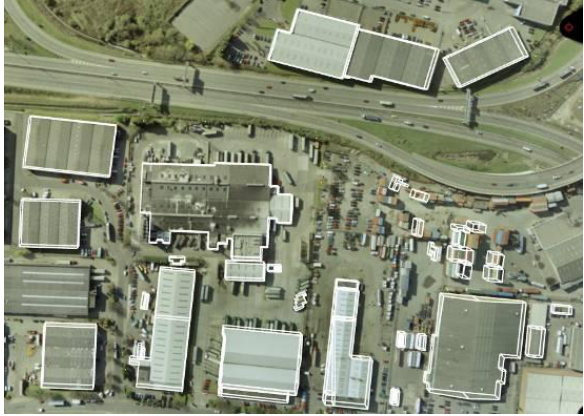
Figure 4. AFE extracted 59 buildings and 13 trees from dense LIDAR. White lines are building boundaries.